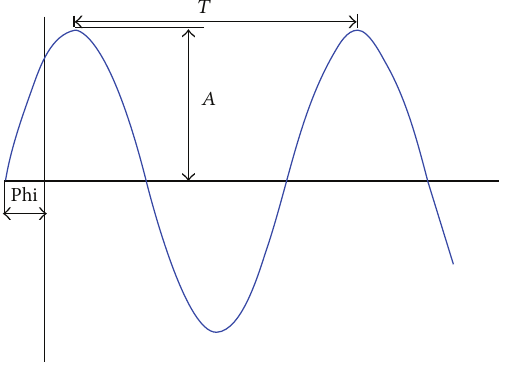
Figure 10: Fourier series.